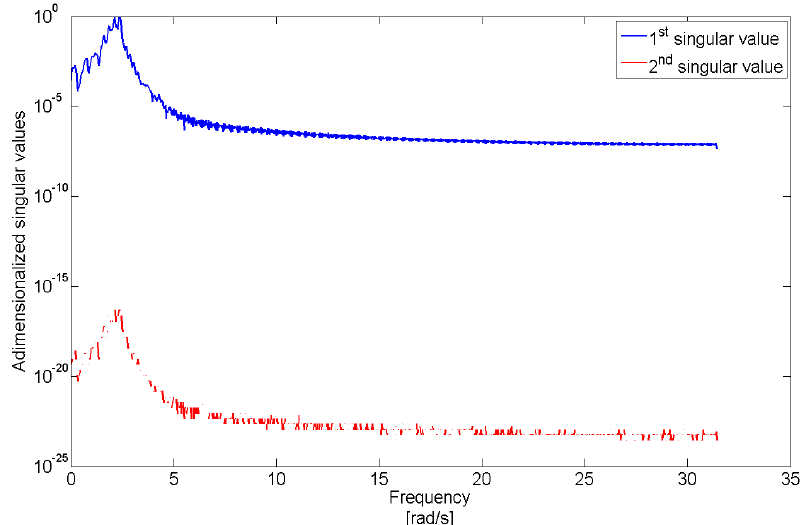
Figure 3. Singular value plot for a 2-DOF system where the two modes have the same natural frequency.